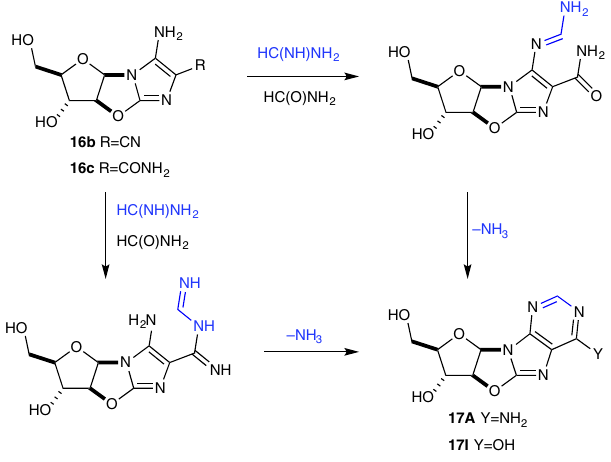
Figure 5 | Aminoimidazole formylation. Incubation of aminoimidazole ( 16b–c ) in formamidine/formamide solution yields anhydropurines 17A and 17I , respectively. Formamidine and hydrogen cyanide in formamide provide comparable yields for formylation of 16c , whereas formamidine provides an excellent yield of 17A from 16b likely exploiting the electrophilicity of the nitrile moiety of 16b